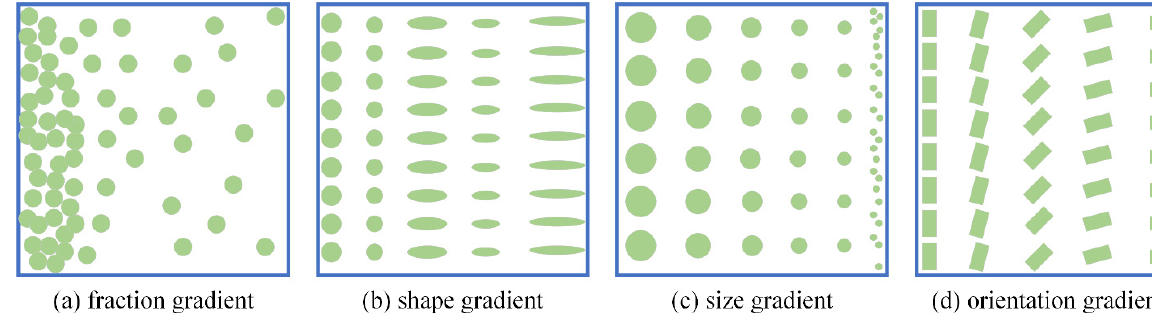
Figure 1. Various types of gradients in FGMs [5].